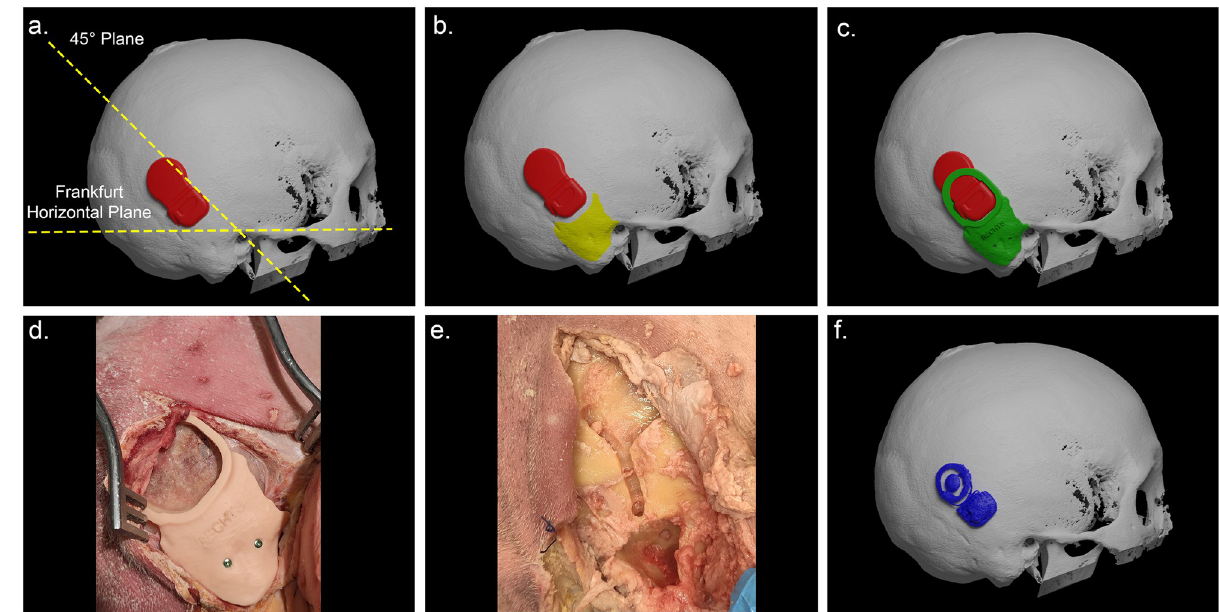
Fig 1. Planning, guide design and surgical procedure using the 3D-printed guide on a cadaveric head. (a) The 3D model of the cochlear implant (CI, shown in red) aligned with a 45˚ plane relative to the Frankfurter Horizontal plane, originating from the external auditory canal (EAC). (b) The skull surface of the mastoid bone and the suprameatal crest used as contact areas (marked yellow on the skull). (c) Surgical guide depicted in green. (d) The surgical guide in place on a cadaveric head. (e) Surgical guide removed with a clear view of the drilled cortical recess. (f) Segmented 3D model of the implanted CI based on the postoperative CBCT scan (shown in